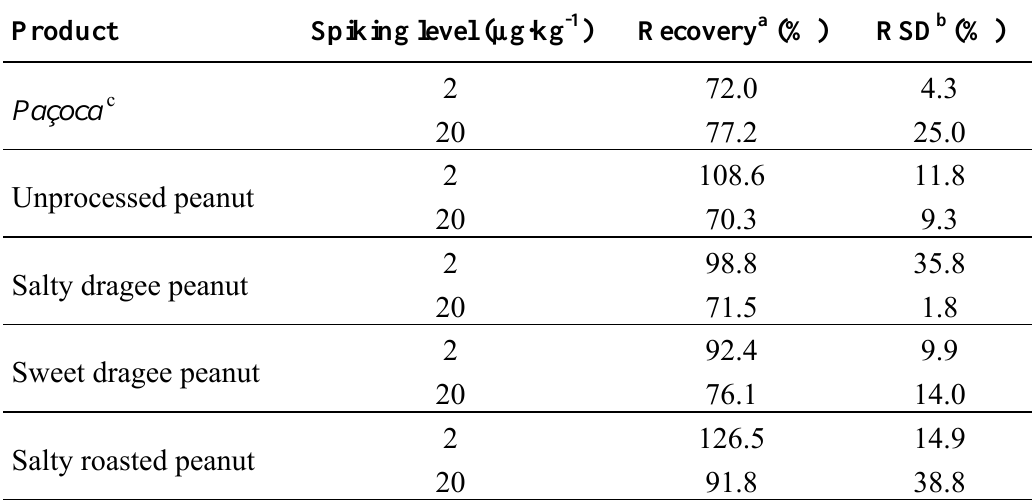
Table 2. Recoveries of aflatoxins in spiked samples of peanut